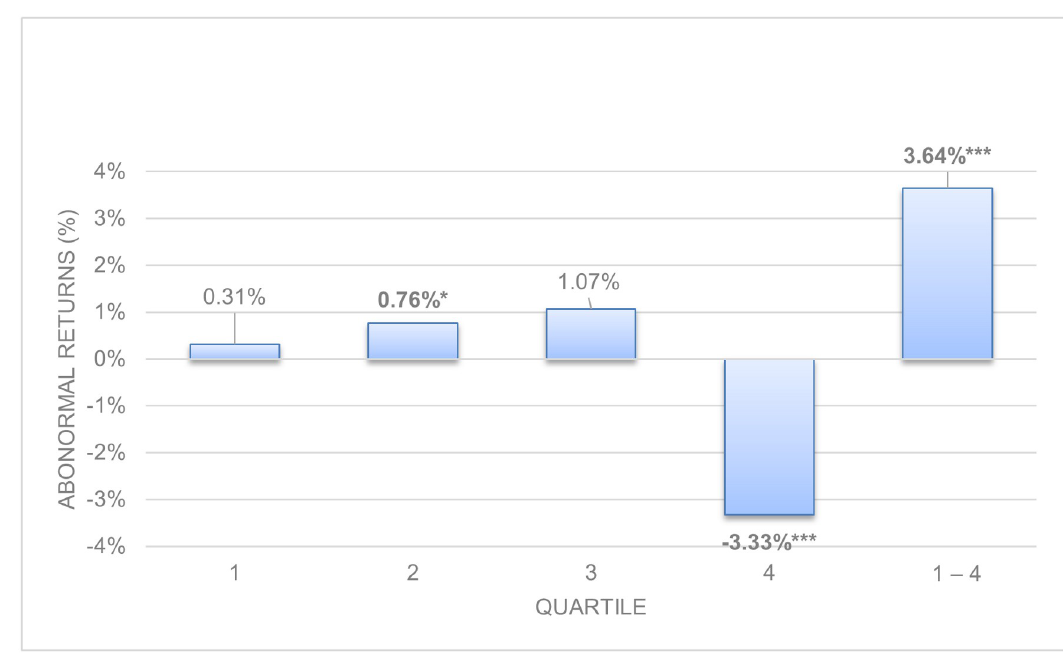
Fig 2. Size-adjusted abnormal returns. Working capital accruals.